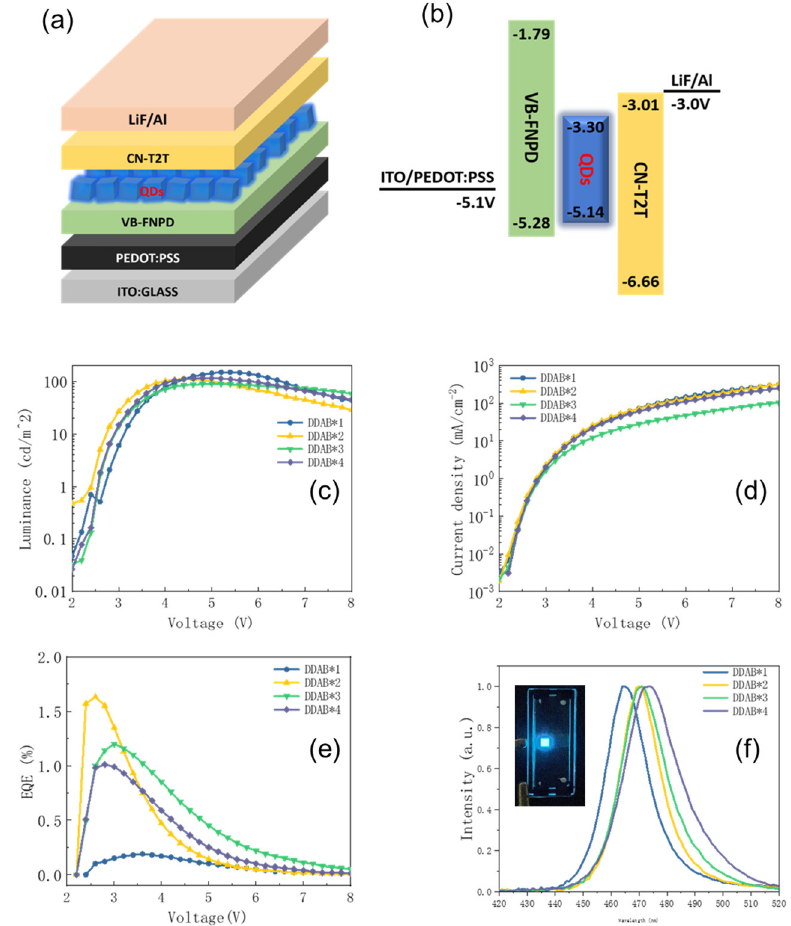
Figure 6. ( a ) Schematic diagram of structure and ( b ) energy level diagram of the blue PQLED device; ( c ) luminance − voltage curve, ( d ) current − voltage curve, ( e ) EQE − voltage curve and ( f ) EL spectra of the PQLED device based on CsPbCl x Br 3 − x PQDs treated by different DDAB concentrations. The inset in ( f ) is the photo of DDAB*2 Device.